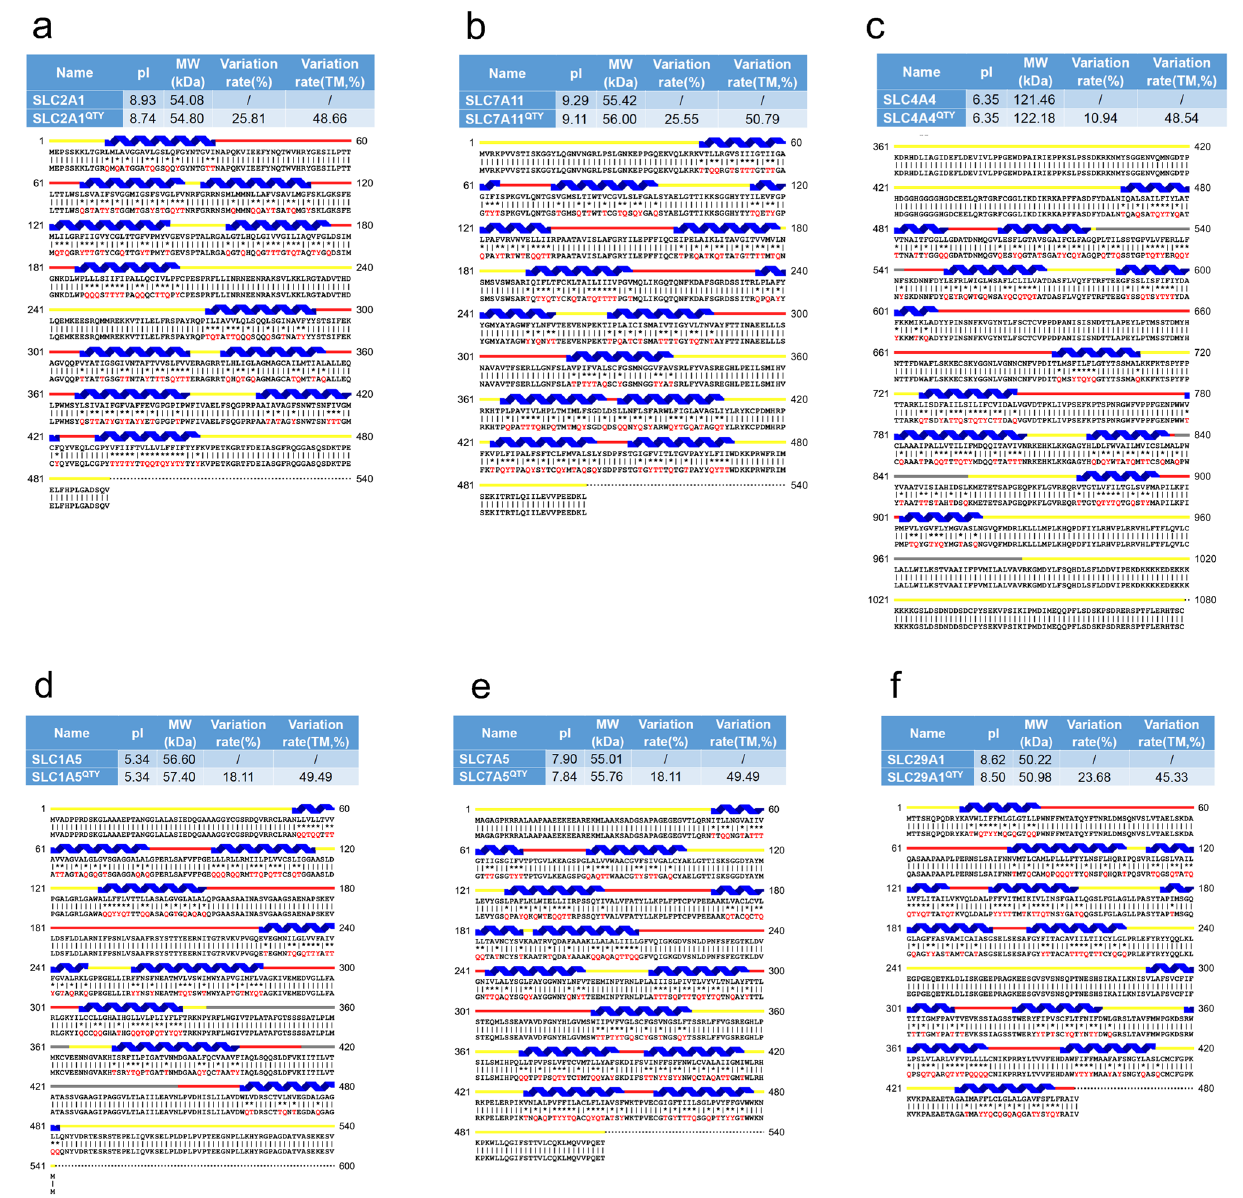
Figure 1. Protein alignments of six solute carrier transporters with their QTY variants. The symbols | and * indicate the identical and different amino acids, respectively. Please note the Q, T and Y amino acid replacement (red). The alpha-helices (blue) are shown above the protein sequences. The loop color codes are: internal (yellow) and external (red). Features of natural and QTY variants are: molecular weight, pI, total variation % and transmembrane variation %. The alignments are: ( a ) SLC2A1 versus SLC2A1 QTY , ( b ) SLC7A11 versus SLC7A11 QTY , ( c ) SLC4A4 versus SLC4A4 QTY , ( d ) SLC1A5 versus SLC1A5 QTY , ( e ) SLC7A5 versus SLC7A5 QTY , ( f ) SLC29A1 versus SLC29A1 QTY . Although there are significant QTY changes for the TM alpha-helix changes, > 45% for SLC29A1, > 50% for SLC7A11, their changes of molecular weight and pI are insignificant (Table